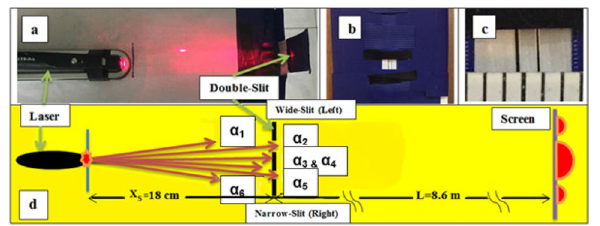
Figure 6. a/ Laser source; b/ Asymmetrical slits and c/ Amplification for measuring their sizes (in mm); d/ 0.18 m) with definition of six horizontal directions of the laser 8.6 m, X Layout of the experiment ( L S = = α 6 . beam at angles α 1 ÷